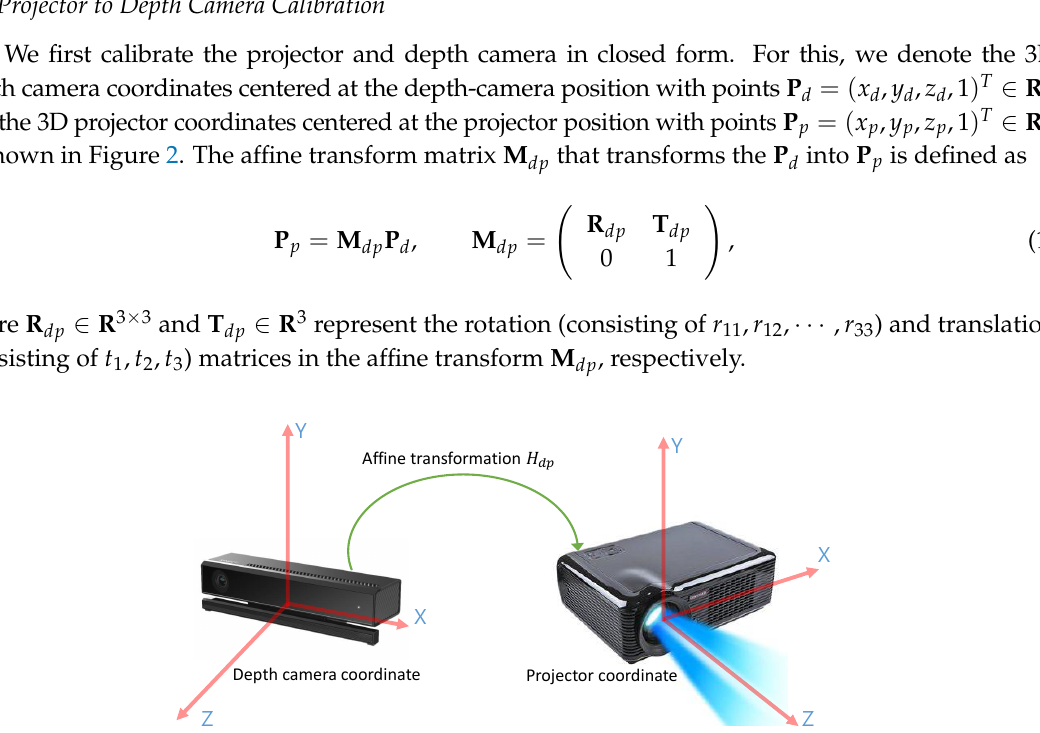
Figure 2. An example of the relation between the depth camera and projector coordinates, where the affine transform matrix M dp transforms the depth camera coordinates ( P d ) into the projector coordinates ( P p